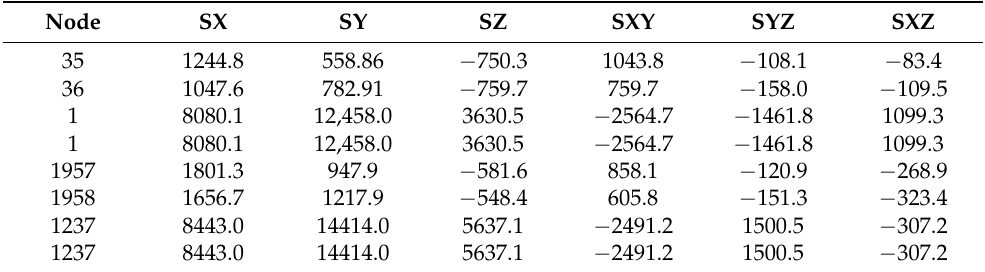
Table 1. Element 565 (SOLID95) with maximum circumferential tensile stress (Pa) when ξ 2 = 0.1. Node SX SY